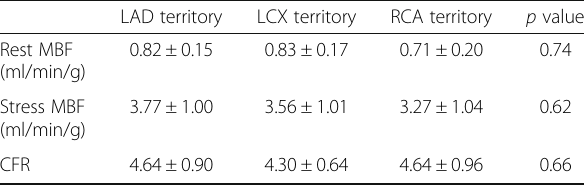
Table 3 Regional myocardial blood flow and coronary flow reserve of